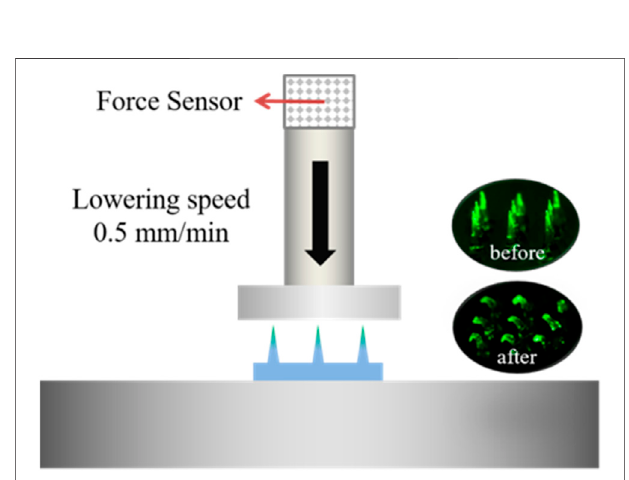
FIGURE 3 | Schematic of testing mechanical property of dissolving MNs. The green fl uorescence indicates the FITC-insulin loaded in the MN